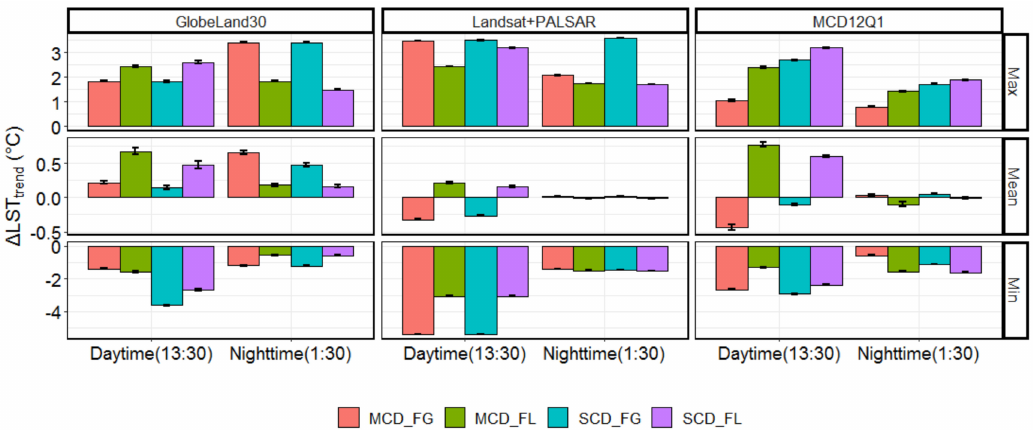
Figure 7. Annual daytime (~13:30 p.m.) and nighttime (~01:30 a.m.) LST di ff erences caused by the three dataset-based forest loss (MCD_FL, SCD_FL) and gain (MCD_FG, SCD_FG) estimated by MCD and adjusted SCD from